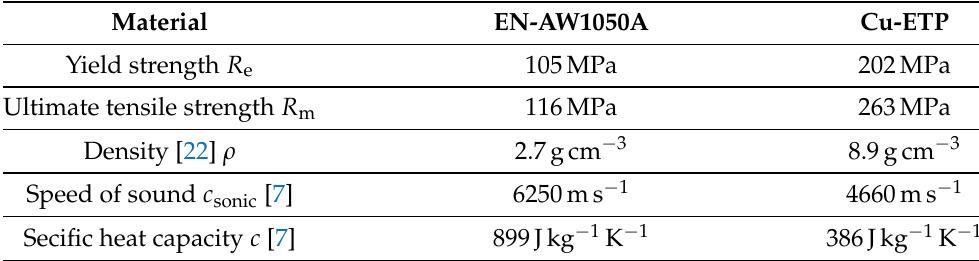
Table 1. Used material data of aluminum EN-AW1050A and copper Cu-ETP.